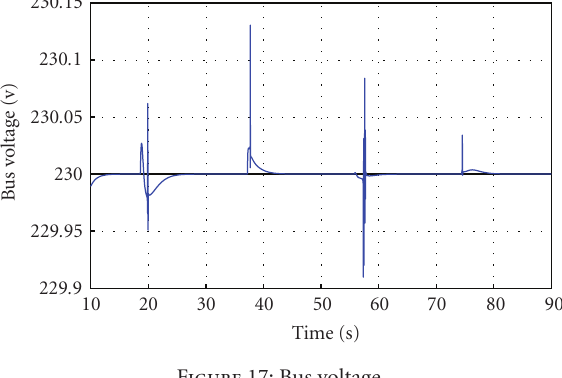
Figure 17: Bus voltage.